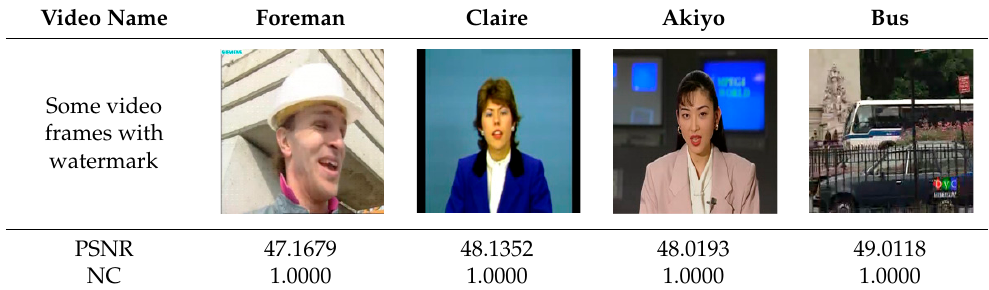
Table 2. Invisibility experiment results without attack.